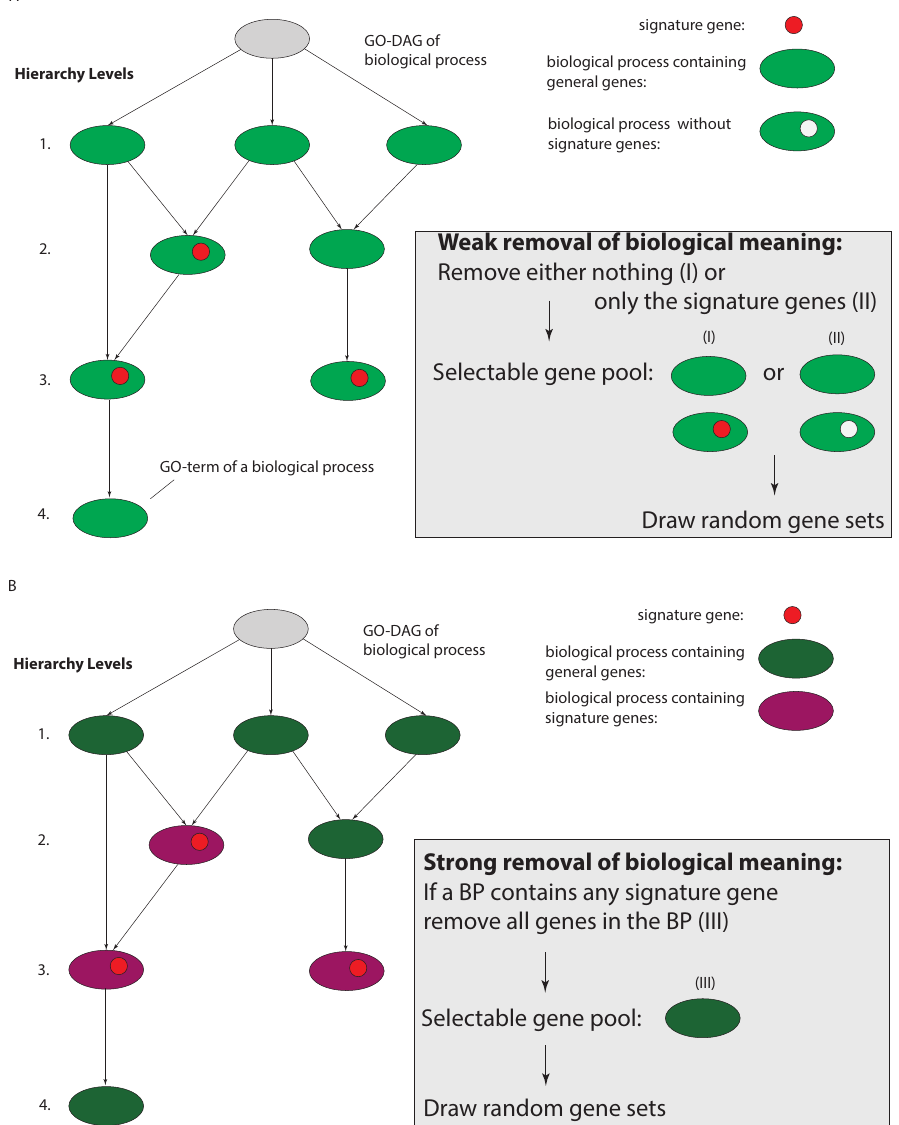
Figure 3. Visualization of three different ways to remove ‘biological information’ from a pool of available genes. The hierarchical trees on the left-hand side are showing directed acyclic graphs (DAG) corresponding to the entire GO database of biological processes (BPs). For a weak removal of biological meaning there are two ways, one allows genes from all BPs (I) and one that removes only the signature genes (II) ( A ). In contrast, a strong removal selects only genes from GO-terms that do not contain any signature gene ( B